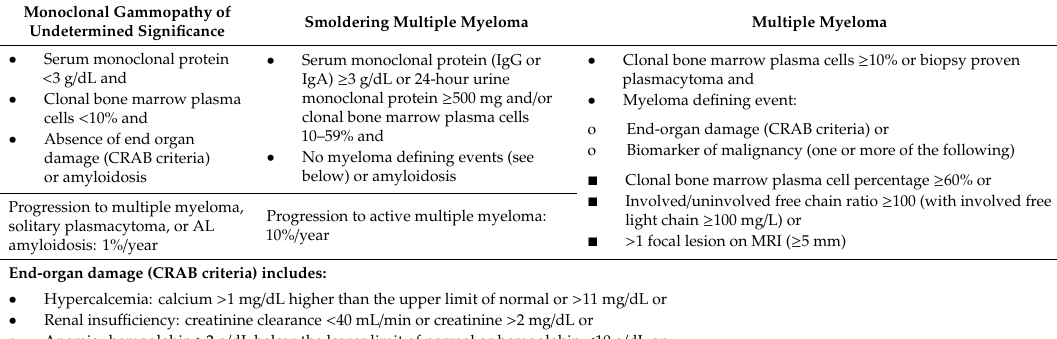
Table 1. Criteria for diagnosis of monoclonal gammopathy of undetermined significance, smoldering multiple myeloma, and multiple